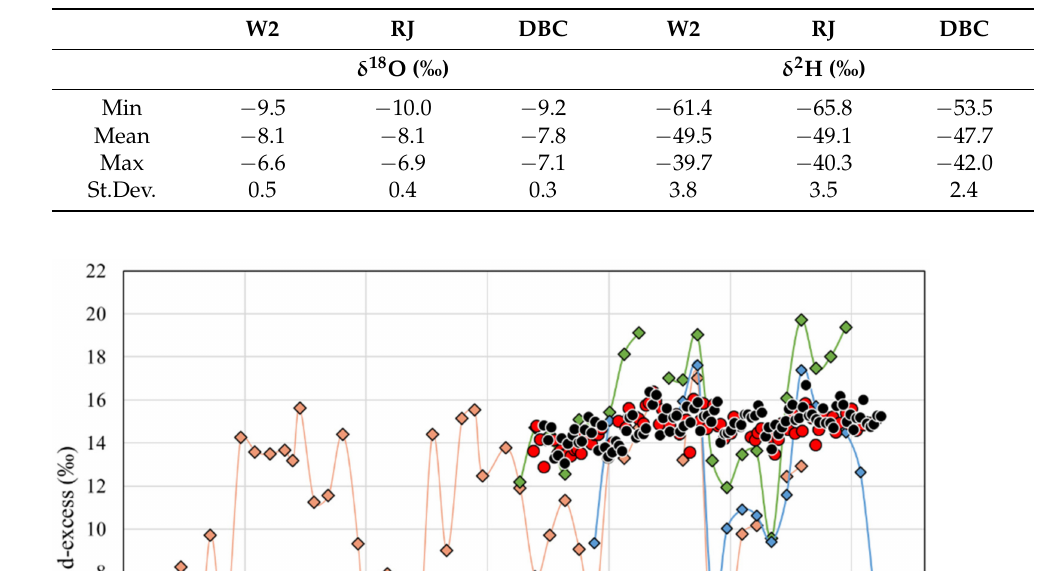
Table 3. Basic statistics of isotopic composition of groundwater. W2—Martinš´cica wells, RJ—Rjeˇcina Spring, DBC—Dobrica.